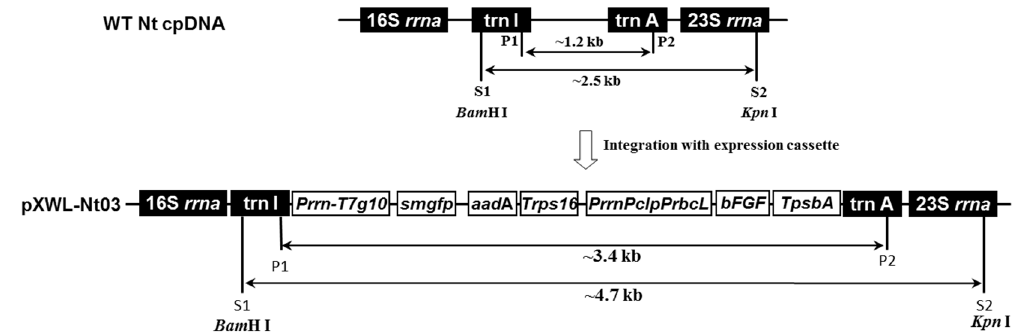
Figure 1. Construction of chloroplast transformation vector pXWL-Nt03. pXWL-Nt03 vector flanked with chloroplast regions of 16S-trnI and trnA-23S comprised a synthetic expression cassette containing the smgfp reporter gene and aadA selectable marker gene. These two genes were jointly driven by the Prrn-T7g10 promoter and the terminator was 3’ untranslated regions (UTR) rps16 (T rps16 ). The target basic fibroblast growth factor ( bFGF ) gene was driven by the fusion promoter PrrnPclpPrbcL previously described [26] and psbA 3’ UTR as terminator (T psbA ). P1/P2 and S1/S2 indicated the primers used for PCR and digestion sites for Southern blot analysis, respectively. A ~3.4 kb fragment was amplified for transplastomic plants, but a ~1.2 kb fragment in wild-type tobacco chloroplast DNA (WT Nt cpDNA) without expression cassette. Similarly, total DNA was digested by BamH I and Kpn I for Southern blot analysis. A ~4.7 kb signal was hybridized for transplastomic plants, but only a ~2.5 kb for untransformed plants.